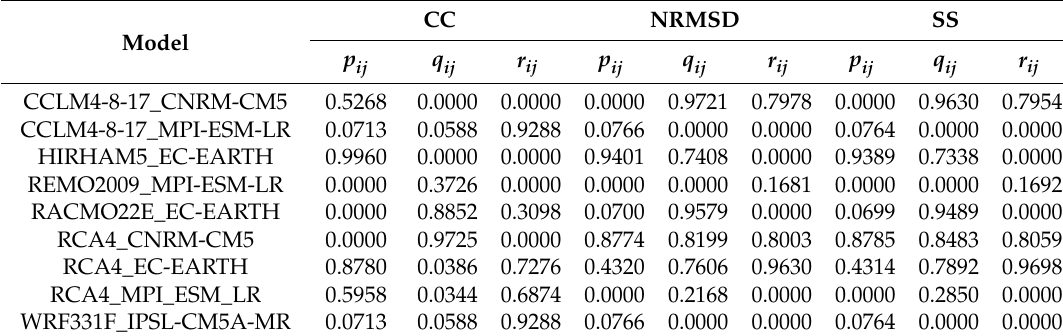
Table 6. Ranking pattern of global climate models.